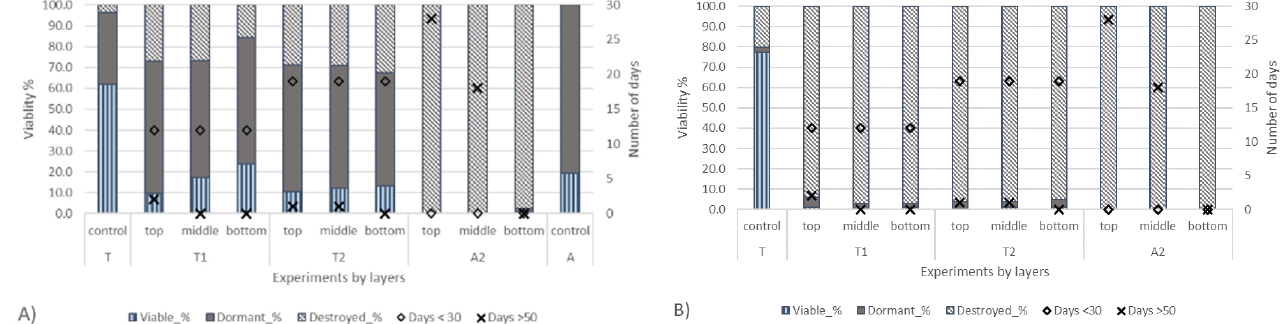
Figure 6. Proportion of viable, dormant and destroyed ( A ) Lupinus polyphyllus Lindley and ( B ) L. polyphyllus × Regalis after one-month tunnel (T1, T2) and four-month windrow composting experiment (A2) and in their control samples. Results are separated based on layers (top, middle and bottom). Temperature is included as days < 30 °C and days > 50 °C for each layer during one month.